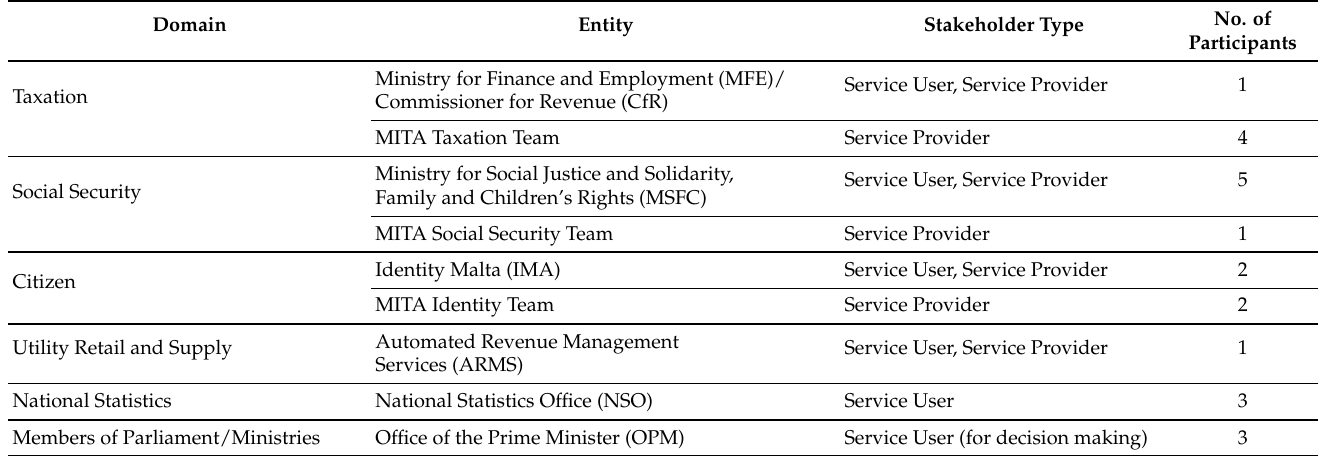
Table 1. Overview of participants in focus